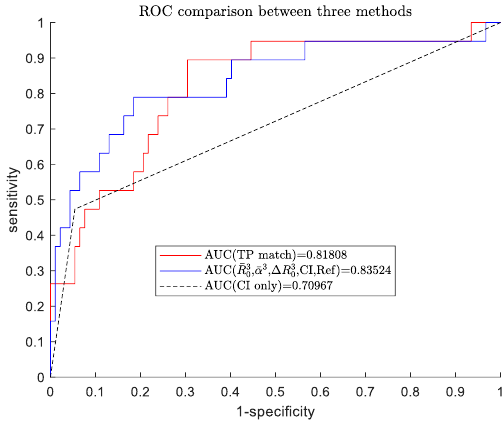
Fig.3: ROC comparison between new method, template match method and colposcopy only.